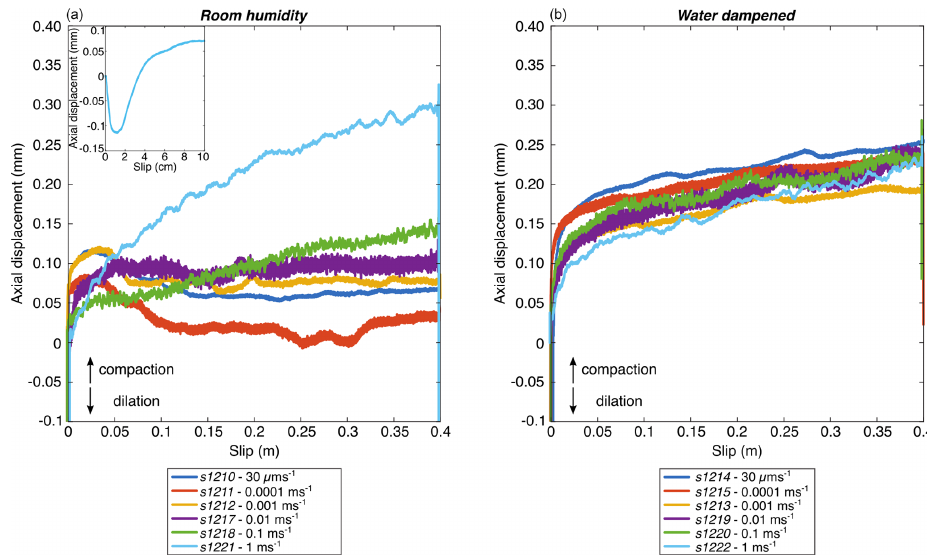
Figure 4. Gouge thickness evolution with slip and slip rate. (a) Under room-humidity conditions and for slip rates of V ≤ 0 . 01ms − 1 , an initial compaction phase was followed by dilation (lasting 0.1–0.15m) and then constant thickness. At higher slip rates ( V ≥ 0 . 1ms − 1 ), after a short initial dilatancy phase, the gouge compacted constantly throughout the whole experiment, with compaction rate increasing with slip rate. (b) Under water-dampened conditions, the gouge compacted at a similar rate at all investigated slip